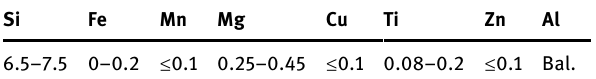
Table 1: Main chemical composition ( % by mass )